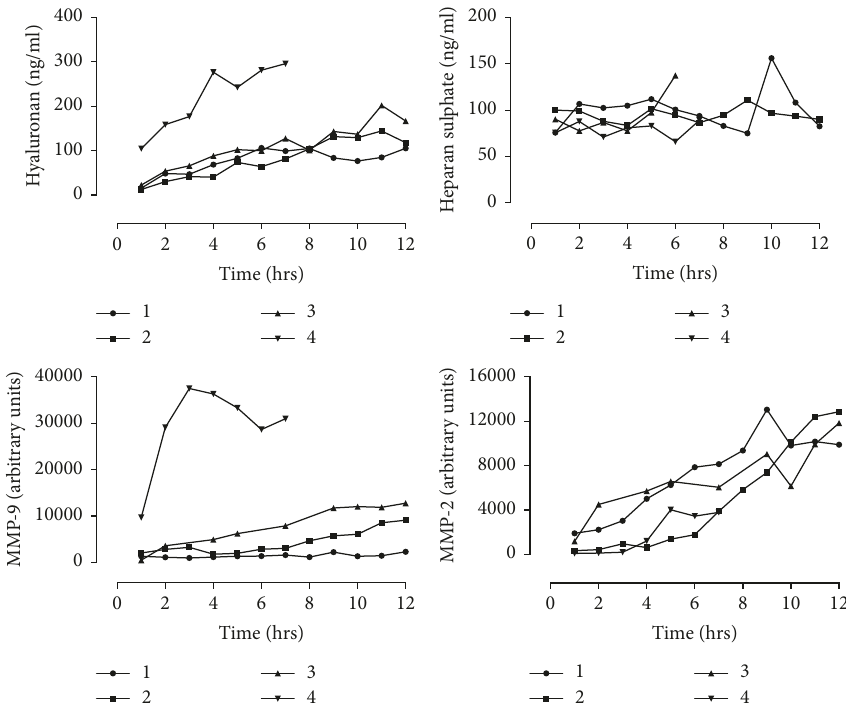
Figure 4: Porcine EVLP perfusate endothelial glycocalyx breakdown products and MMP levels over